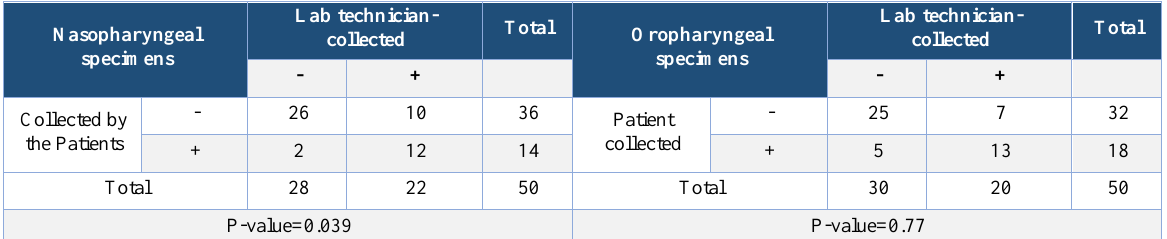
Table 4. Comparative results of novel coronavirus detected in lab technician- and patient-collected naso- and oropharyngeal swabs Nasopharyngeal